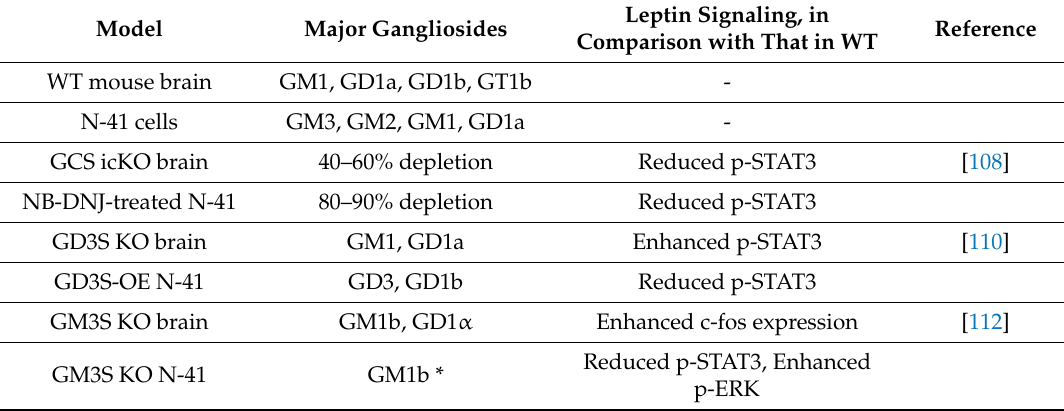
Major gangliosides expressed in mouse brains and N-41 cells with genetically or pharmacologically modified GSLs and their leptin